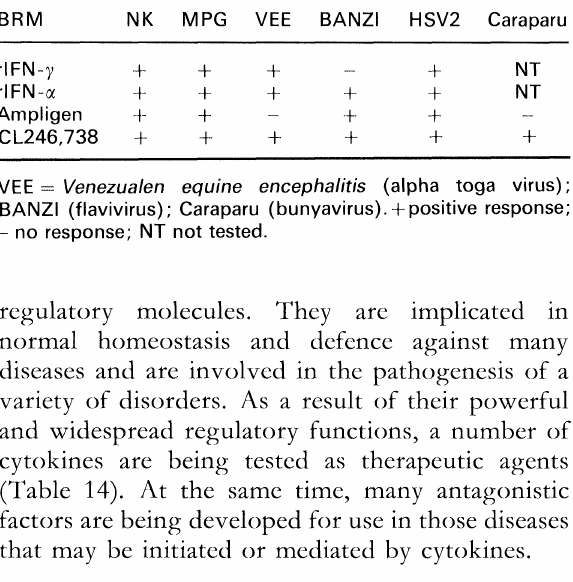
Table 12. Antiviral--in vivo responses